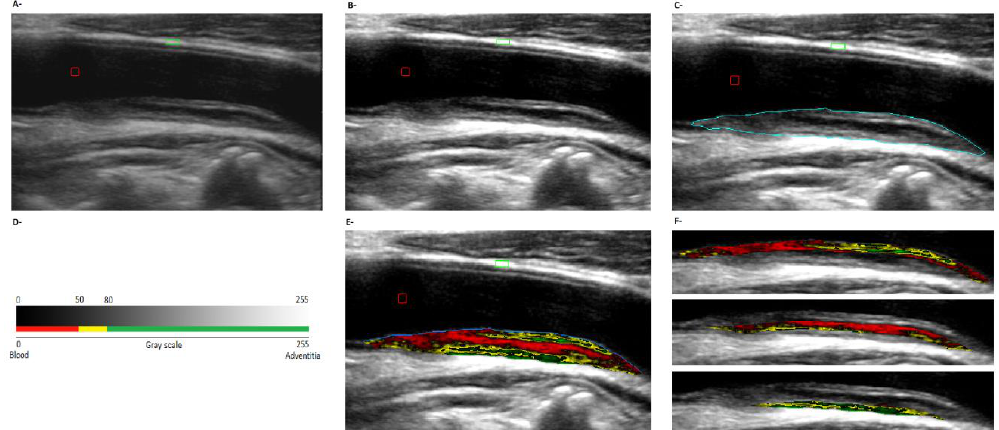
Figure 1. Plaque geometry and composition analysis (plaque located in the common femoral artery, posterior wall). ( A ): Raw (pre-processing) image. Red and green marks indicate, respectively the lumen (blood) and the arterial wall, references for equalization. ( B ): Equalized image. ( C ): Plaque edges determination. ( D ): Grayscale and color map. ( E ): Color map for the whole plaque. ( F ): First, second and third millimeter (sheet) analysis.